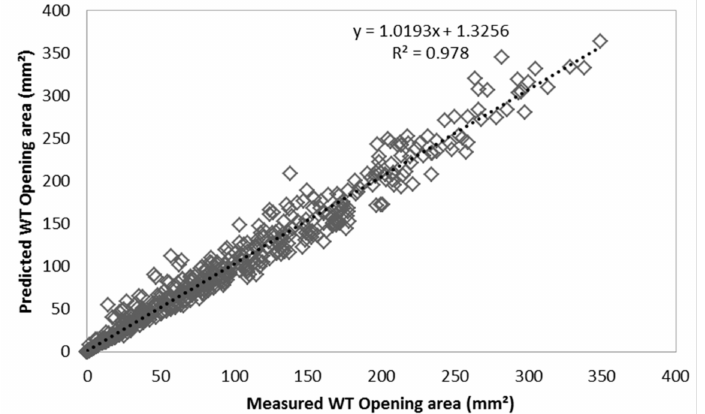
Figure 14. Measured against predicted opening area plotted for the medium-range pressure data in Sample 2 tests. R 2 = 0.978. Table 4. The correlation coefficient R 2 of the measured against predicted opening area plots for Samples 1, 2 and 3 using Root Mean Square (RMS) values of the height and width of the valve opening. Opening